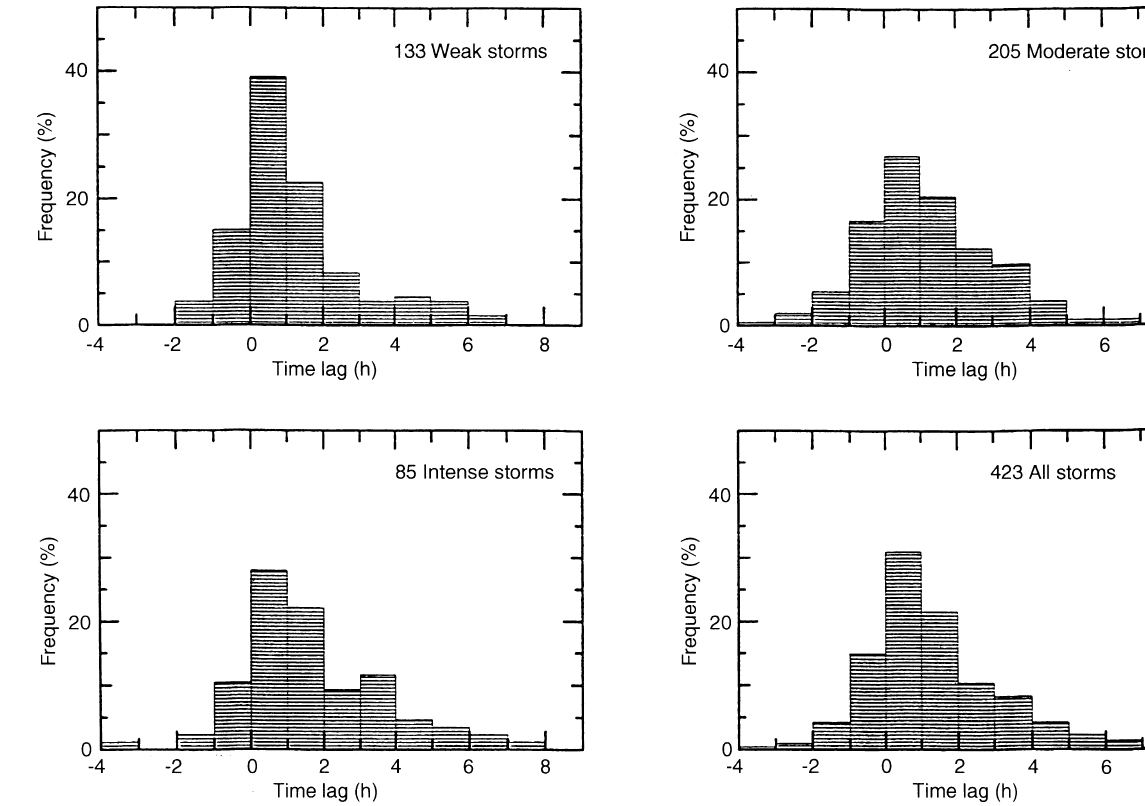
Fig. 2. The time lag t D (cid:255) t A , where t A and t D show the times of the lowest latitude of the auroral boundary and of the minimum Dst , respectively. The four panels show the histograms for di(cid:128)erent storm categories: weak storms (cid:133) Dst min (cid:21) (cid:255) 50nT (cid:134) , moderate storms